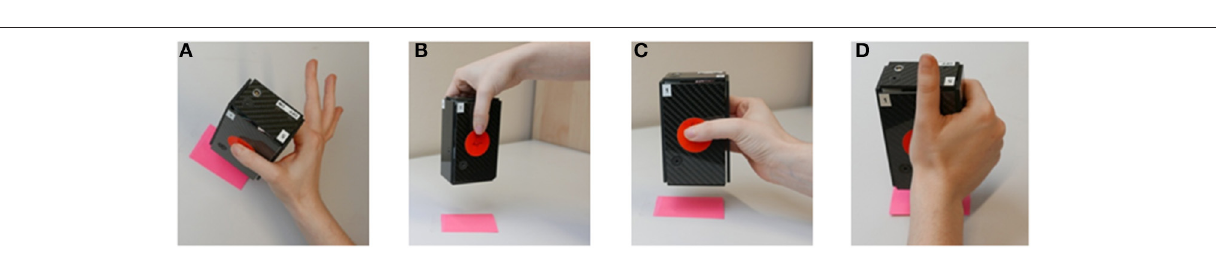
FIGURE 2 | Grasp configurations used during the iBox protocol. (A) Precision grip. (B) Top grasp. (C) Pinch grip. (D) Palmar-digital grasp. Image adapted from Martin-Brevet et al. (57). task. Patients were asked to perform each grasp and place task 3 times to the best of their ability. The ensemble of grasping and holding tasks were performed first with the less affected arm and then with the hemiparetic arm. The experimenter verified the patient’s initial posture and repositioned the iBox between movements as